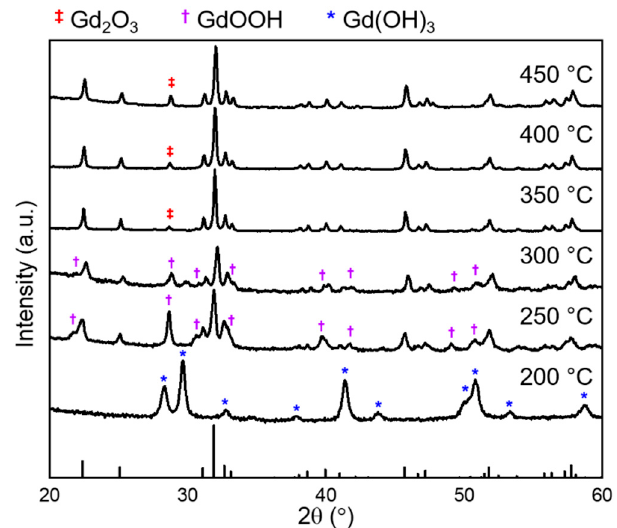
Figure 1. PXRD patterns of the products obtained from reaction attempts of GdScO 3 at a single temperature between 200 and 450 ◦ C for 2 days. The calculated pattern for GdScO 3 is plotted on the bottom. Gd(OH) 3 (blue *) was the only crystalline product formed at 200 ◦ C, implying that ∆ G rxn , as defined later in the text, is positive. Between 250 and 300 ◦ C, both GdScO 3 and GdOOH (purple † ) are formed, suggesting ∆ G rxn is negative but small in absolute value. Above 300 ◦ C, GdScO 3 is the primary phase, with only a small amount of Gd 2 O 3 (red ‡ ) as a secondary phase, so ∆ G rxn is negative and large in absolute value.